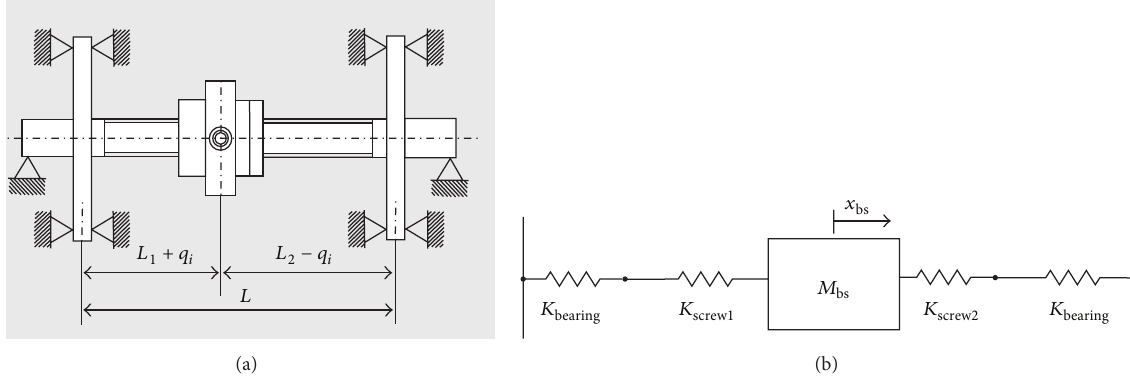
Figure 5: (a) Ball-screw shaft fixed at both ends and (b) mass-spring model of the axial deformation of the ball-screw.